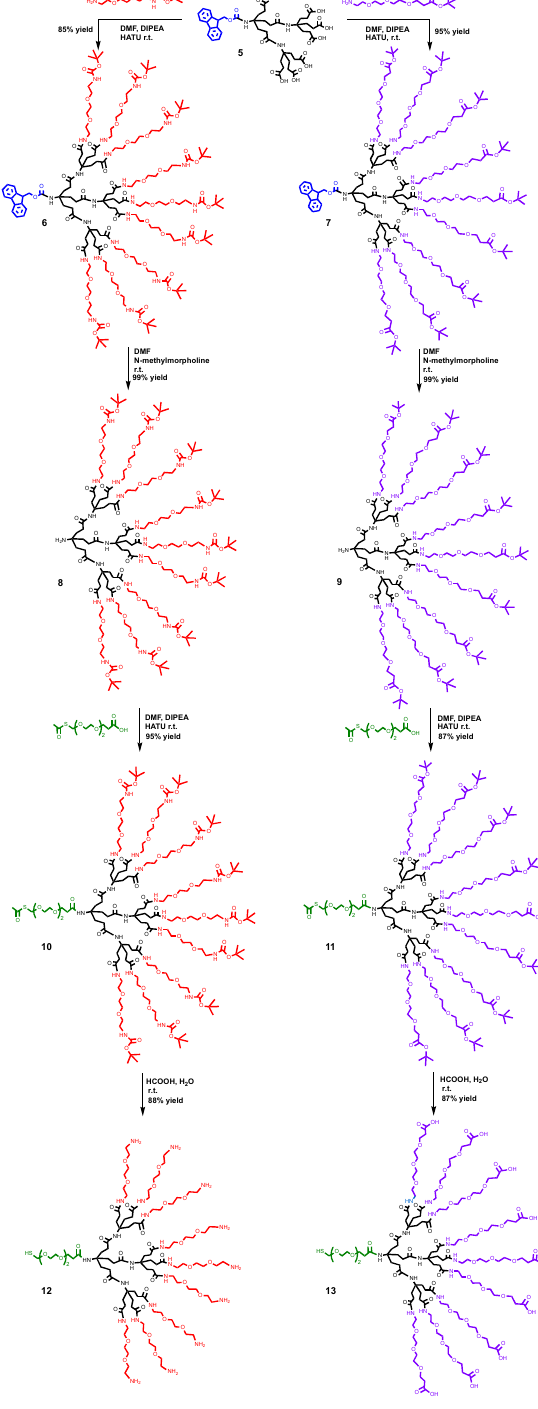
Scheme 2. Synthesis of two dendrons with a thiol group at the focal point and nine amine or carboxylic acid termini.